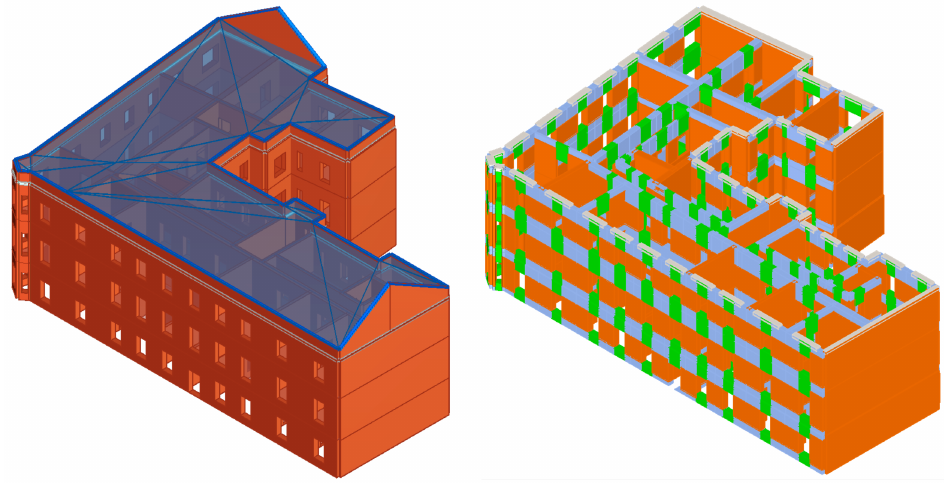
Figure 14. The 3D model and the 3D equivalent frame of the building in 3Muri12